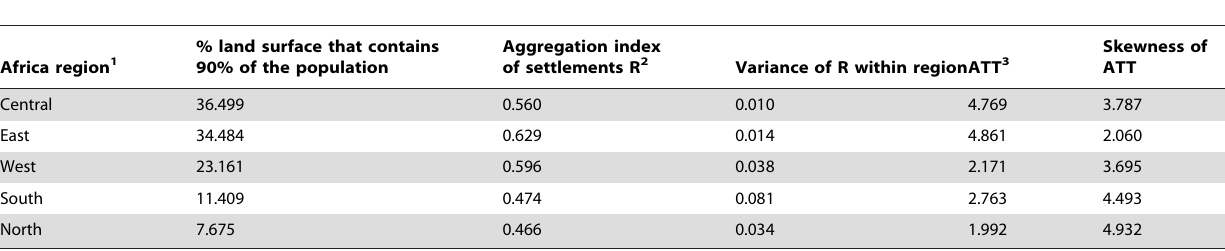
Table 1. Settlement patterns, population distribution and accessibility measures calculated for the 5 geographical regions of Africa.